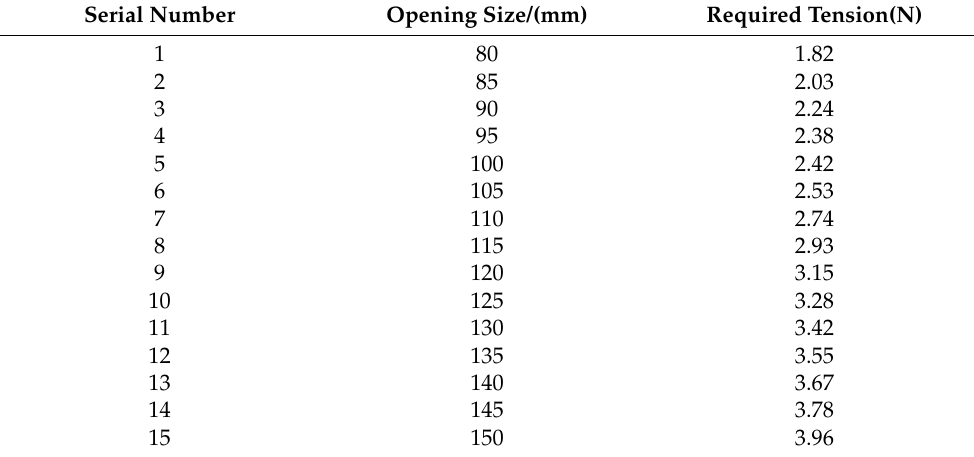
Figure 6. ( a ) Experiment on shrinkage characteristics of the net sleeve; ( b ) The net opening is too large and poorly wrapped; ( c ) Optimal wrapping of the net sleeve. Table 2. Experimental results of the effect of the opening size of the foam mesh sleeve on its shrinkage characteristics.